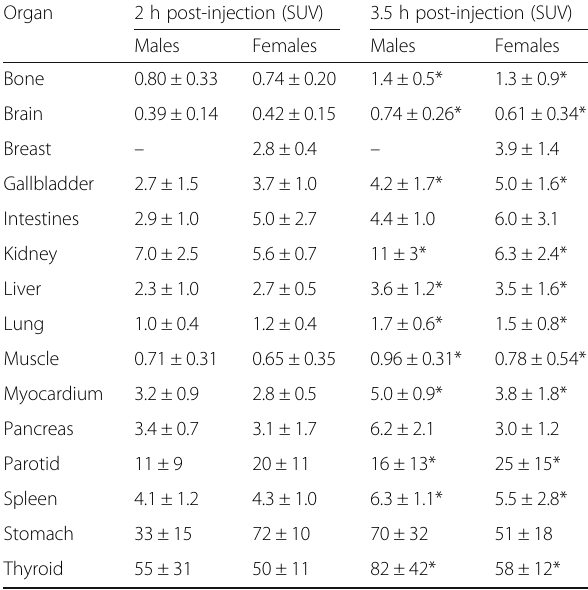
Table 3 PET/CT-derived distribution of 18 F-TFB in